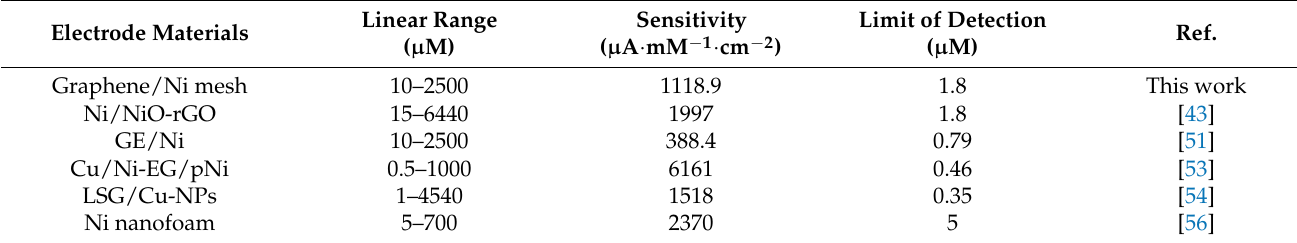
Table 3. Comparison of various glucose biosensors. rGO: reduced graphene oxide; GE: graphene; pNi: porous Ni; LSG: laser scribed graphene; NPs: